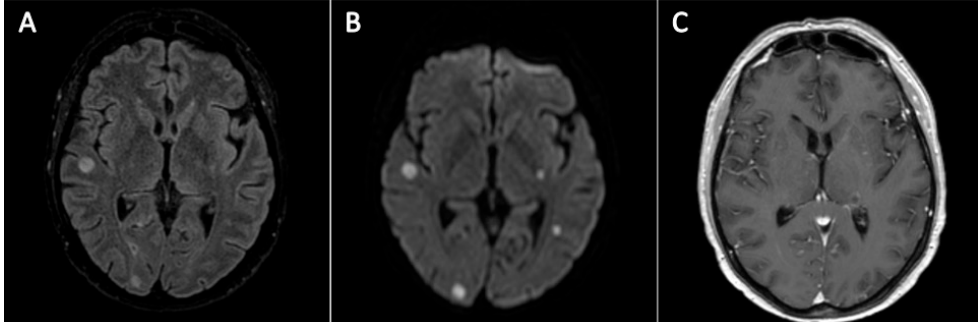
Figure 1. Magnetic resonance imaging of the brain for case 1. Findings were consistent with septic emboli. Pictures ( A ) and ( B ) show multifocal superficial and deep bilateral rounded lesions, some of which show nodular or ring-like enhancement after contrast injection (left thalamus in picture ( C )). Lesions were localized at both sub- and sovra-tentorial level, with a miliary distribution, the largest ones involving the cerebellum and the brainstem with a maximum diameter of about 10 mm. In addition, phlogistic mucosal thickening of paranasal cavities was documented (not shown). ( A ): FLAIR sequence; ( B ): DWI sequence; ( C ): T1-post Gadolinium sequence.